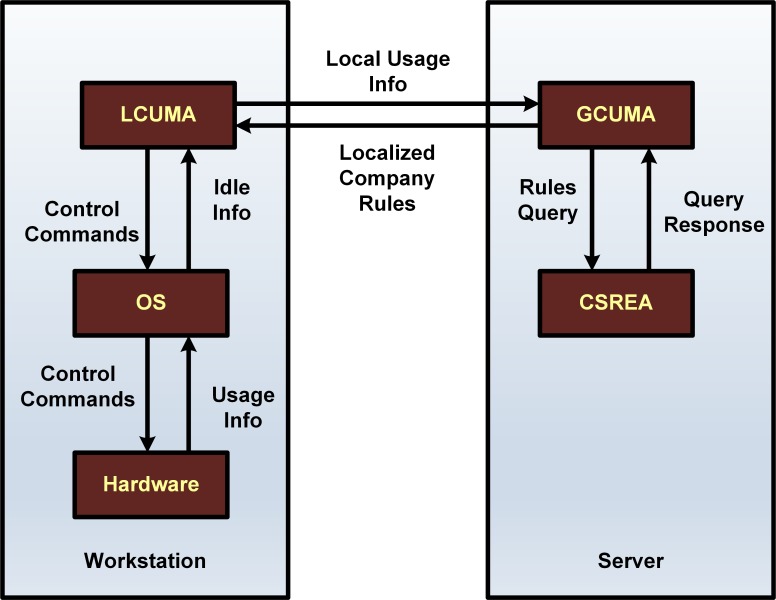
MASMINC Architeture.